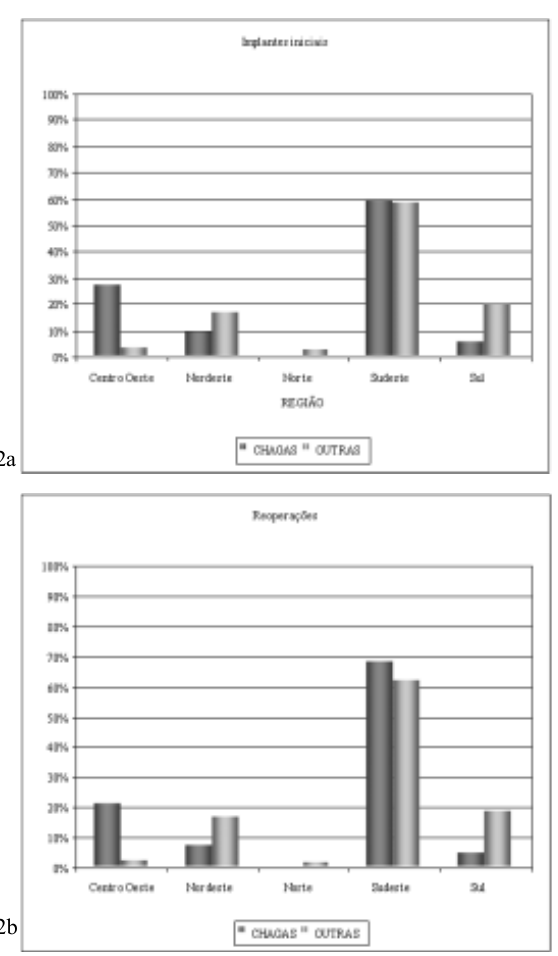
Fig. 2 - Distribuição dos procedimentos nas diferentes regiões brasileiras, no implante inicial (2a) e nas